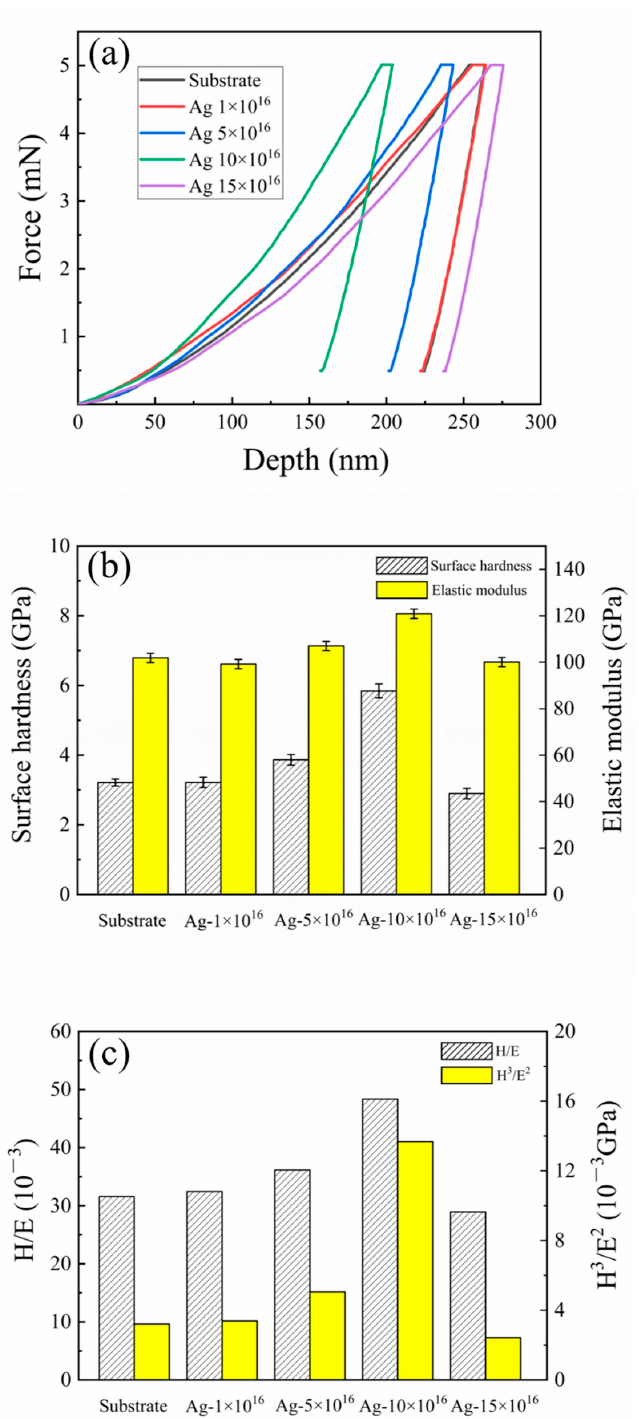
Figure 9. ( a ) The curve of the displacement and load for the substrate and different doses of Ag-implanted specimens; ( b ) the surface hardness and elastic modulus for substate and different doses of Ag-implanted specimens; ( c ) the H/E and H 3 /E 2 for substate and different doses of Ag-implanted specimens.